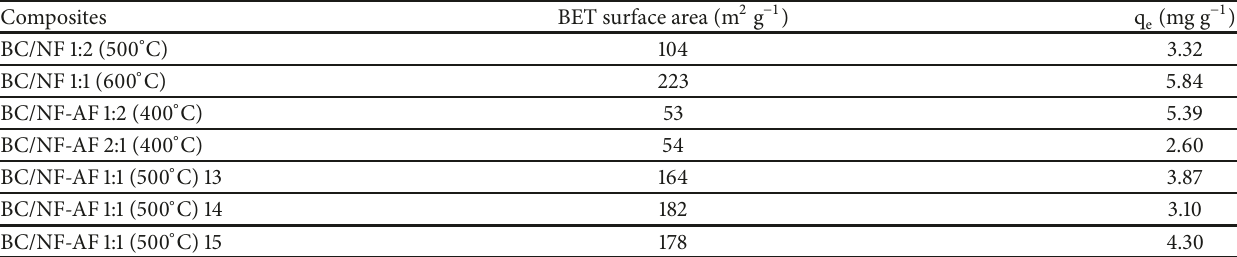
Table 5: BET surface area values of composites with higher adsorption